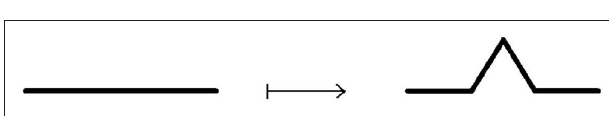
FIGURE 13 | Construction of Koch